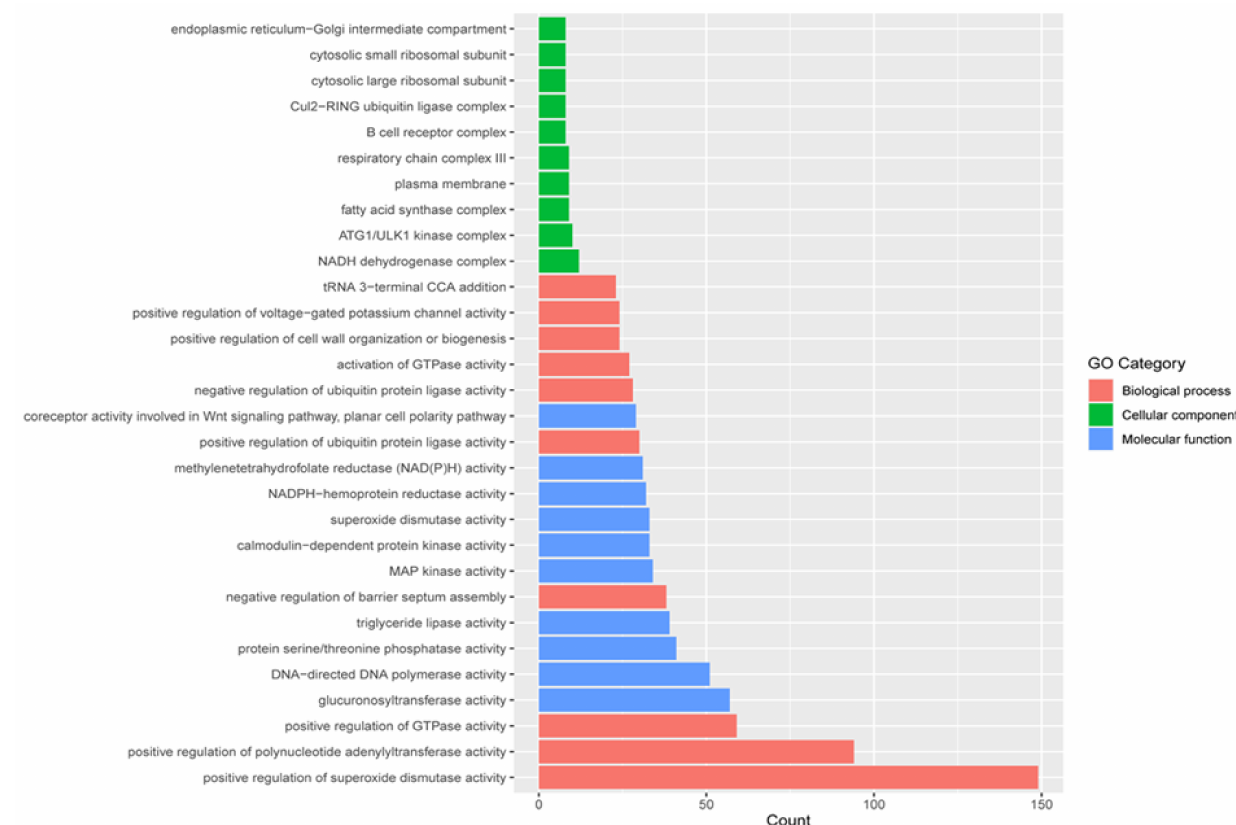
Figure 4. Gene Ontology (GO) classification of wild sea cucumber body wall assembled